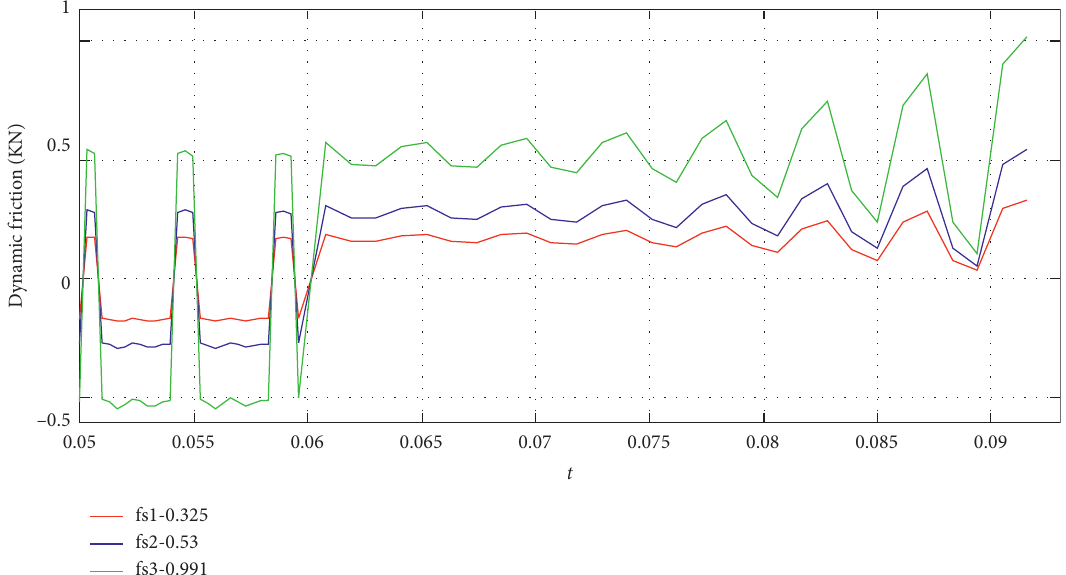
Figure 31: Dynamic friction from the smoothed Coulomb model.